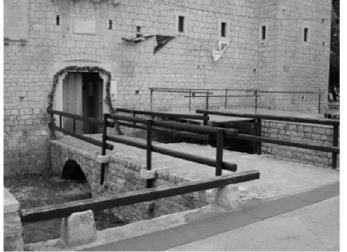
Figure 5. Ri č evica, Kaštel Štafili ć (B2).